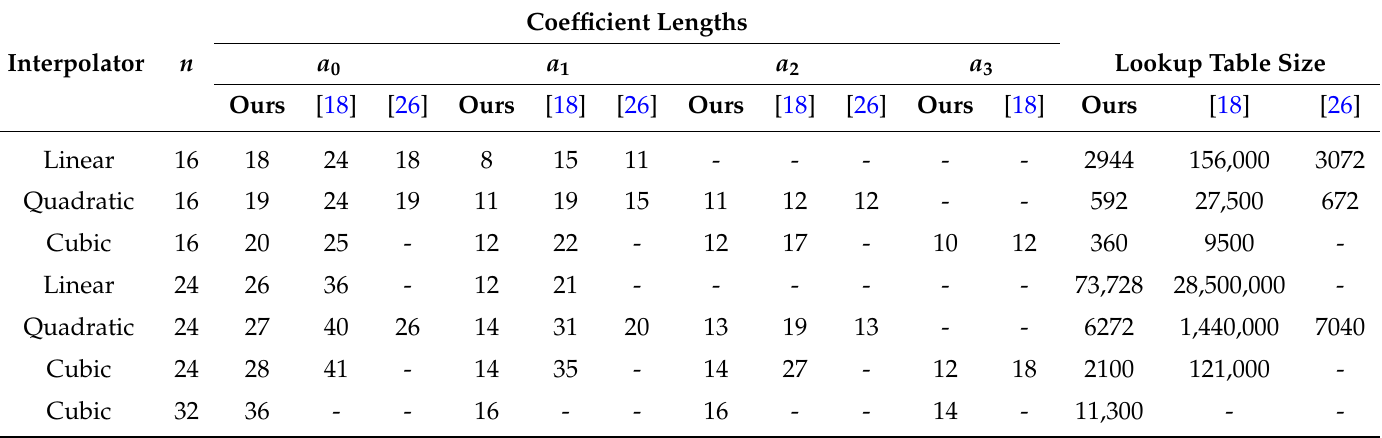
Table 4. Memory requirements for faithfully rounded results, f ( x ) = 1/ x